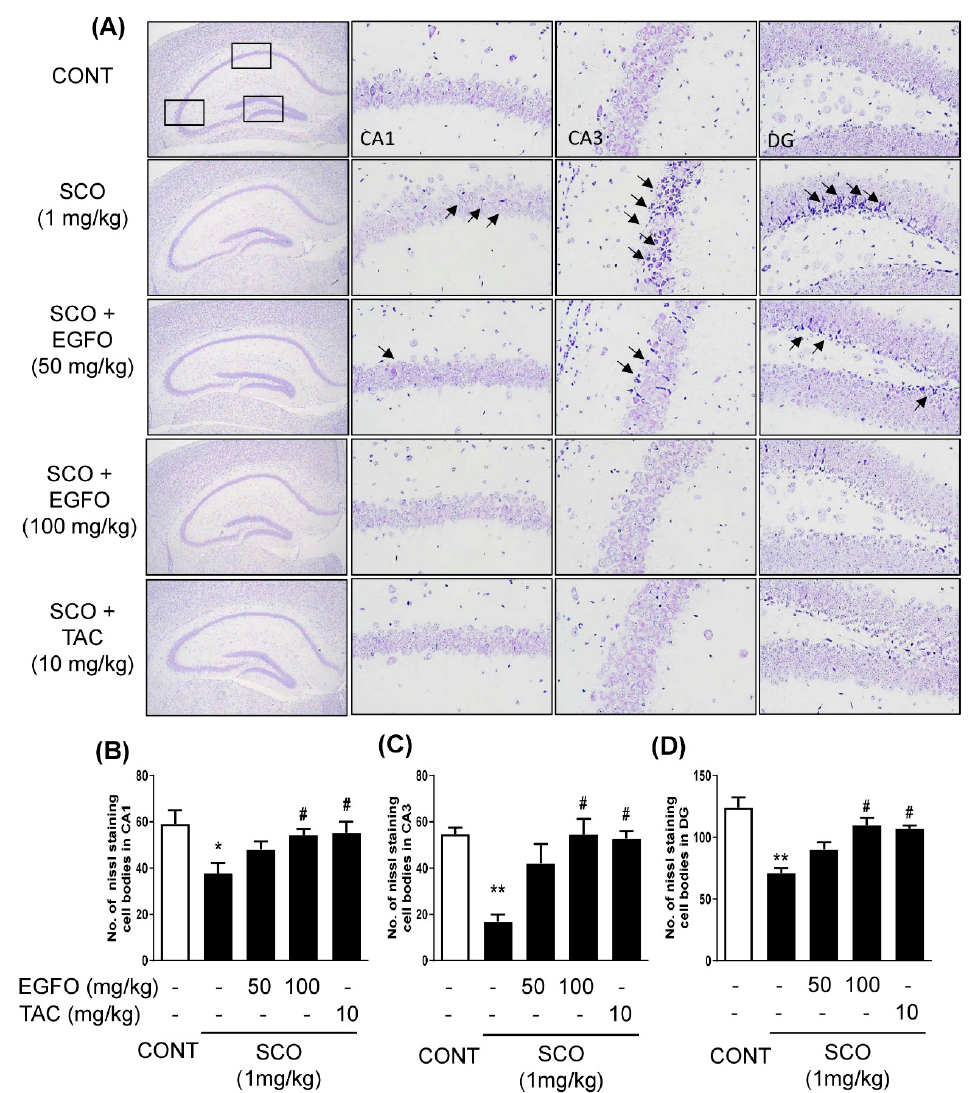
Figure 5. Effect of EGFO extract on morphological damage to neurons in mice with scopolamine-induced memory impairments . Sections of the hippocampal CA1, CA3, and dentate gyrus (DG) were regions were stained with Nissl staining solution. Representative photomicrographs ( A ) are shown at magnifications of 40× (first column) and 400× (from second to fourth column). Bar graphs represent the number of Nissl staining cell bodies in histological sections of the CA1 ( B ), CA3 (C), and DG ( D ).